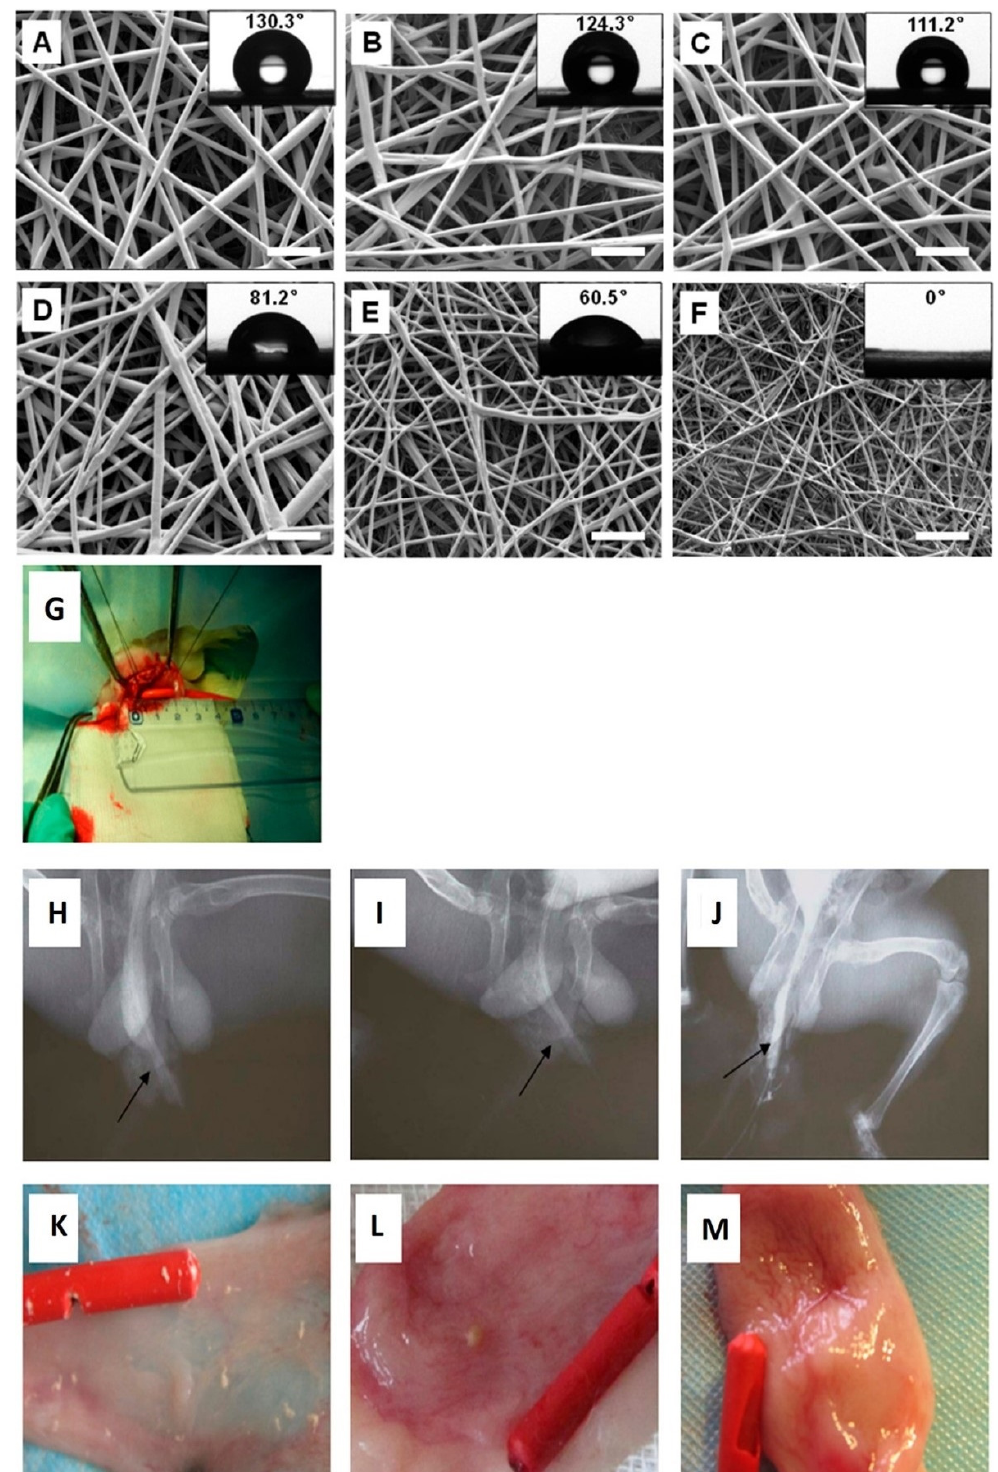
Figure 8. ( A – F ) shows SEM images of PLLA scaffolds with different PEG weight ratios: ( A ) 0%, ( B ) 10 %, ( C ) 20%, ( D ) 30 %, ( E ) 40%, ( F ) 50 %. ( G – M ) show the implantation of PLLA/PEG/ hAMSCs in the rabbit model, and the repair of the urethra defect. ( G ): implantation process. ( H – J ): retrograde urethrograms of animals treated with the mock operation, PLLA/PEG scaffolds, and PLLA/PEG/hAMSCs, respectively. ( K – M ) show the urethra mucosa defect repair and calculi formation in rabbits treated with the mock operation, PLLA/PEG scaffolds, and PLLA/PEG/hAMSCs, respectively. Adopted from reference [219]. Scale bar 10 μ m.